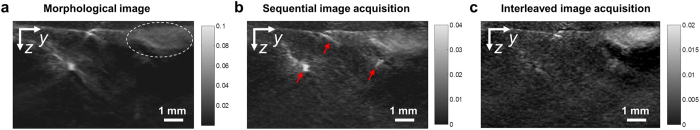
Detection of a NIR fluorophore in vivo using morphological and pump-probe difference imaging: (a) z-y MIP of the morphological image showing the region of Atto680 injection as indicated by the dashed line. (b) z-y MIP of the difference image acquired using sequential acquisition. Red arrows indicate residual motion artefacts due to moving blood vessels. (c) z-y MIP of the difference image acquired using interleaved image acquisition, which provides maximum contrast to the fluorophore.